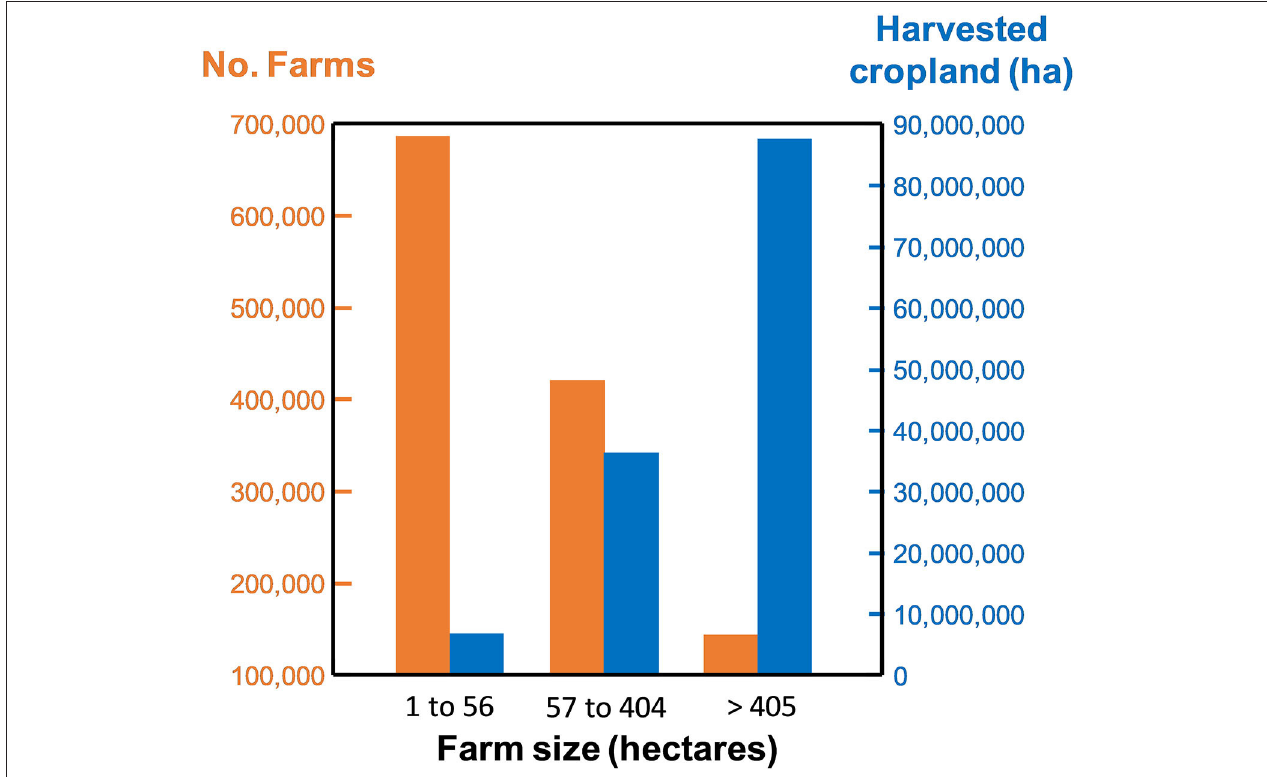
FIGURE 1 | Number of farms with harvested cropland (orange bars) and total harvested cropland (blue bars) by farm size class in the US in 2017. Data are from Table 9 of the 2017 US Census of Agriculture, Census Volume 1, Chapter 1: U.S. National Level Data (USDA NASS, 2019).